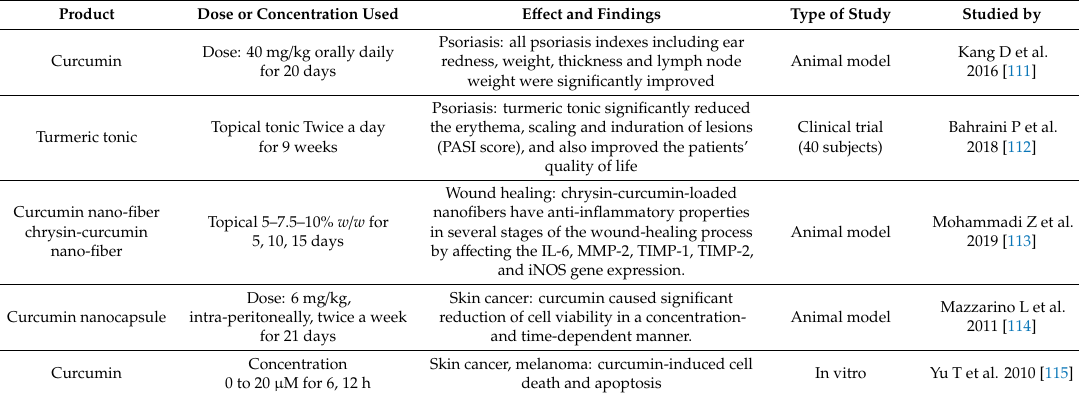
Table 5. Therapeutic E ff ect of Curcumin in skin